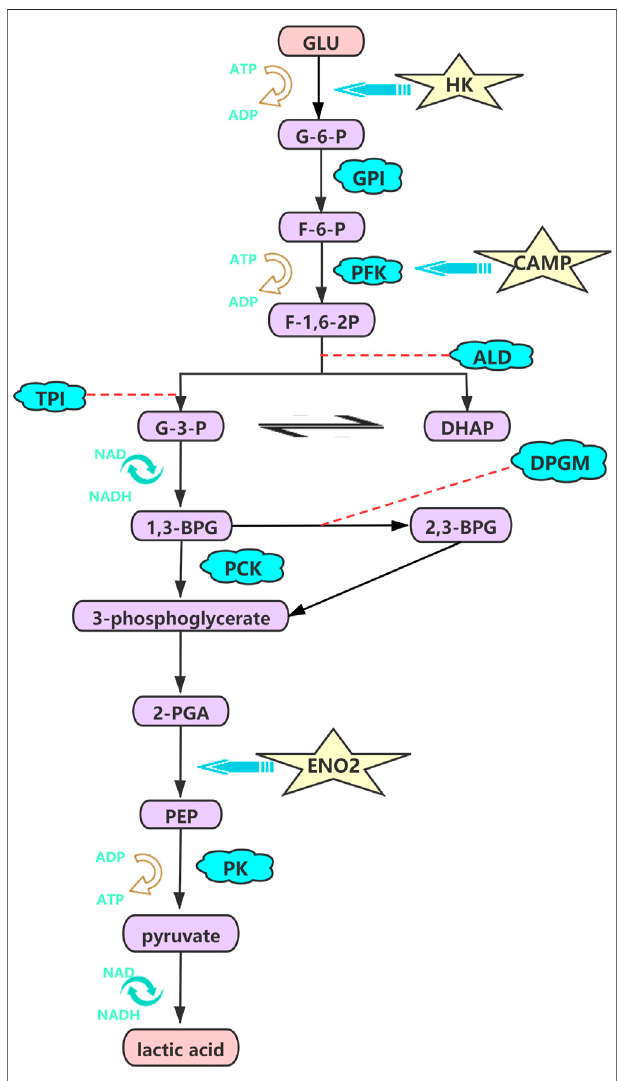
FIGURE 7 | HK, CAMP, ENO2 were high regulated and promote the glycolysis, glucocorticoid resistance, and cell growth processing under hypoxia. The pathway was visualized by the adobe illustrator